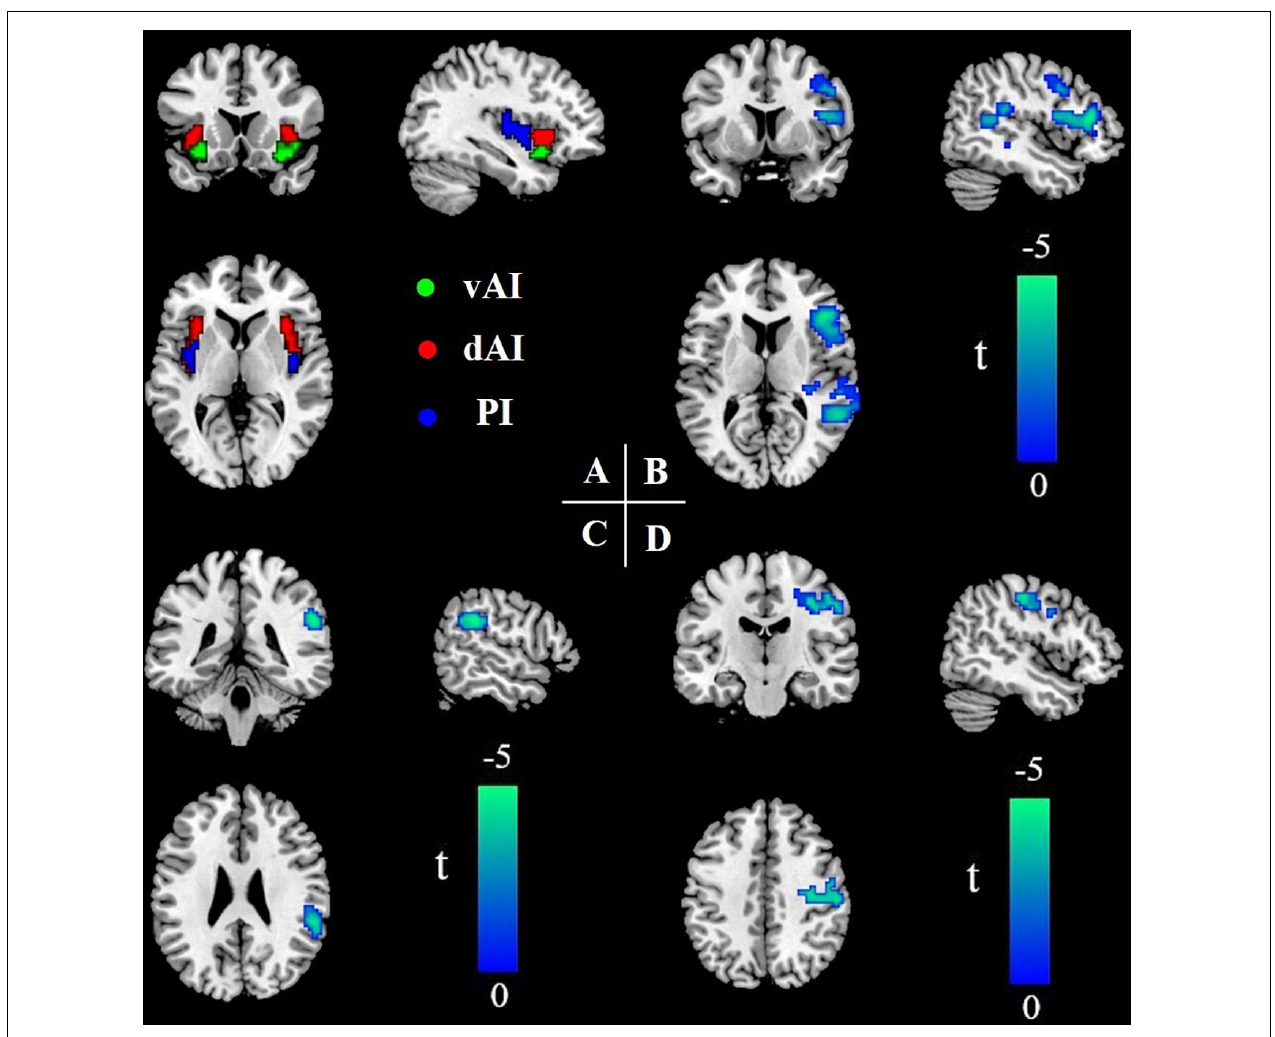
FIGURE 1 | Insular subregions and differences in resting-state FC between the T2DM group and the HC group (two-sample t -test, P < 0.05, GRF-corrected). (A) Bilateral insular subregions, including the dorsal anterior insula (dAI; red), ventral anterior insula (vAI; green), and posterior insula (PI; blue). (B) Reduced FC of